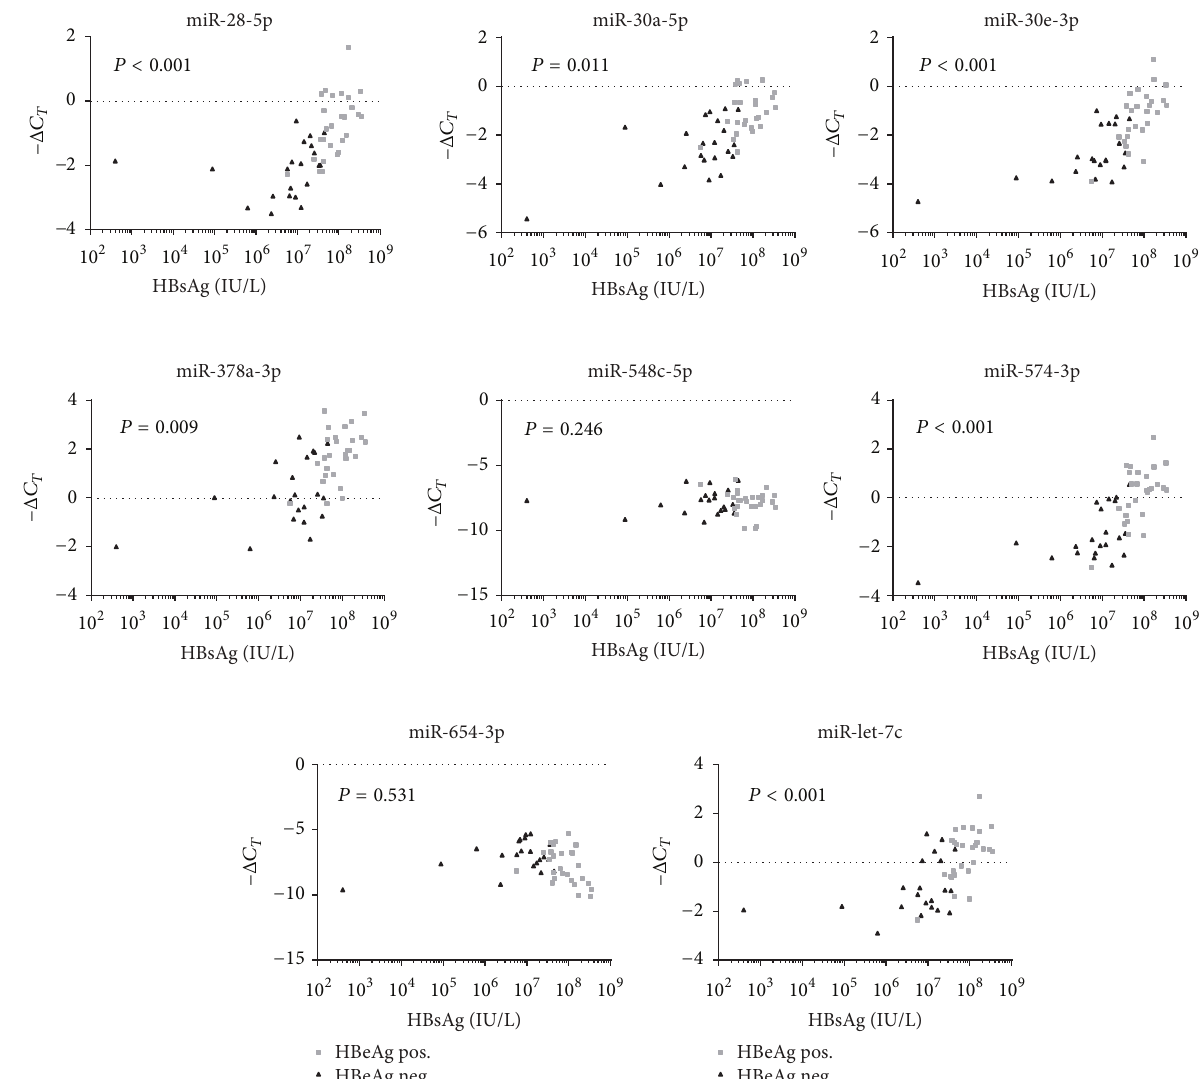
Figure 2: MicroRNA plasma levels and HBsAg quantity. qRT-PCR and HBsAg data on 34 HBeAg-positive and 25 HBeAg-negative children. 𝑃 values are based on multivariate analyses. Due to multiple testing only 𝑃 < 0.0028 was considered significant.